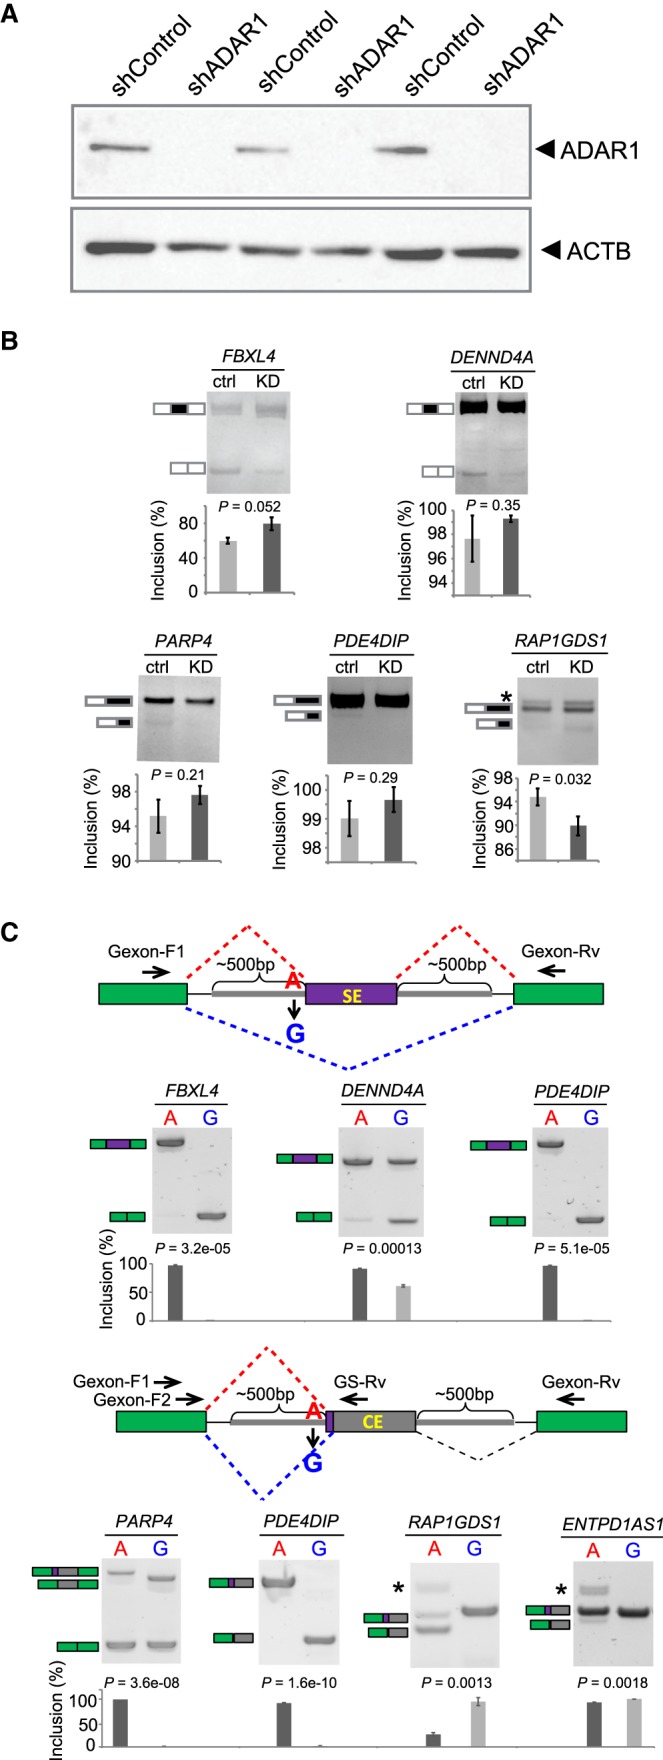
Experimental validation of splicing changes induced by 3′ss editing. (A) Western blot of ADAR1 in U87MG cells stably expressing control shRNA (shControl) or ADAR1 shRNA (shADAR1). Three biological replicates are shown. (B) RT-PCR results of endogenous splicing levels of five randomly chosen exons with 3′ss editing. U87MG cells in A were used. (Ctrl) shControl; (KD) shADAR1. Exon inclusion levels (%) were calculated based on triplicated experiments. One example gel image is shown. Error bars represent standard deviation. P-values were calculated by Student's t-test. (C) Seven randomly chosen editing-dependent alternative splicing events were validated in minigene systems. The minigene designs to validate exon skipping (top) and alternative splice site events (bottom) are shown, respectively. Primers used to amplify the splicing products are shown as arrowheads. In the bottom diagram, Gexon-F1 and Gexon-Rv represent the forward and reverse primers used for PARP4. Gexon-F2 and GS-Rv refer to the forward and gene-specific reverse primers for the other three exons. Exon inclusion levels (%) were calculated based on triplicated experiments. One example gel image is shown. Error bars represent standard deviation. P-values were calculated by Student's t-test.